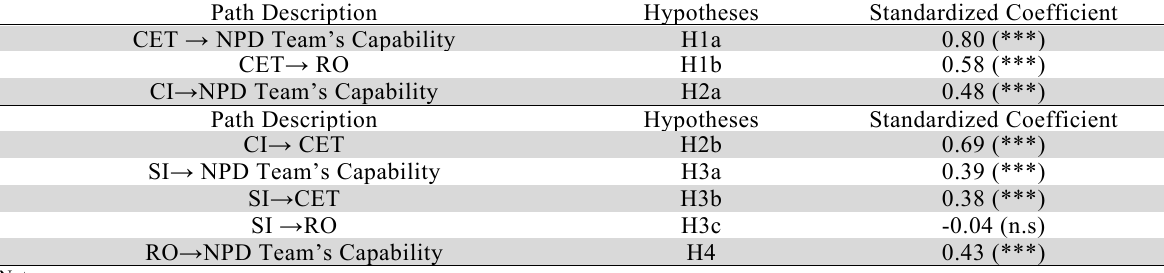
Statistics of Path Estimates obtained from Structural